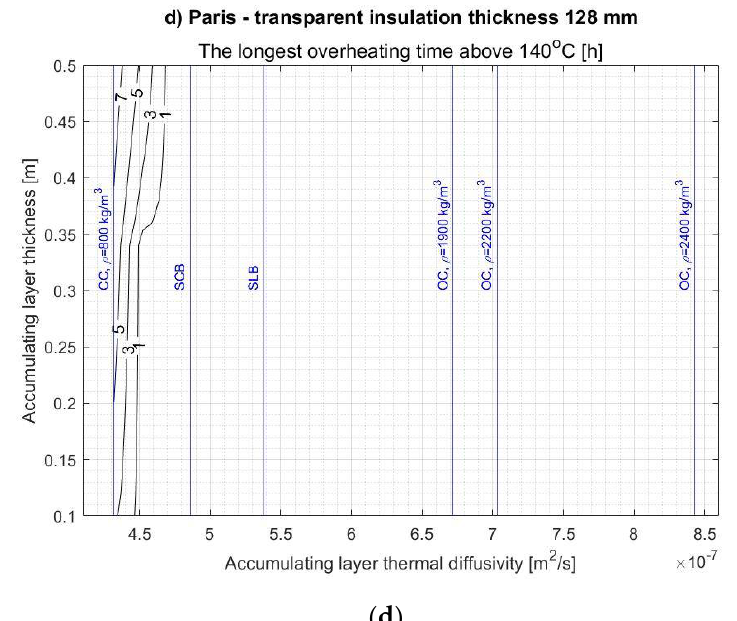
Figure A9. Contour graphs characterizing the SW basic parameters in a function of AL thermal diffusivity and thickness for the whole heating season: ( a ) the heat balance of the SW’s unit area, ( b ) the heating time, ( c ) the mean time lag of the maximum temperature on the absorber and SW’s internal surface during the day, ( d ) the longest overheating time above 140 °C in the TI. TI thickness: 128 mm. Location: Paris.